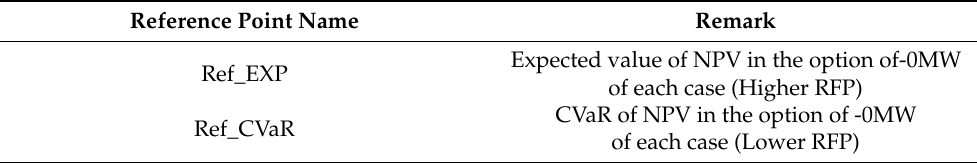
Table 9. Types of reference